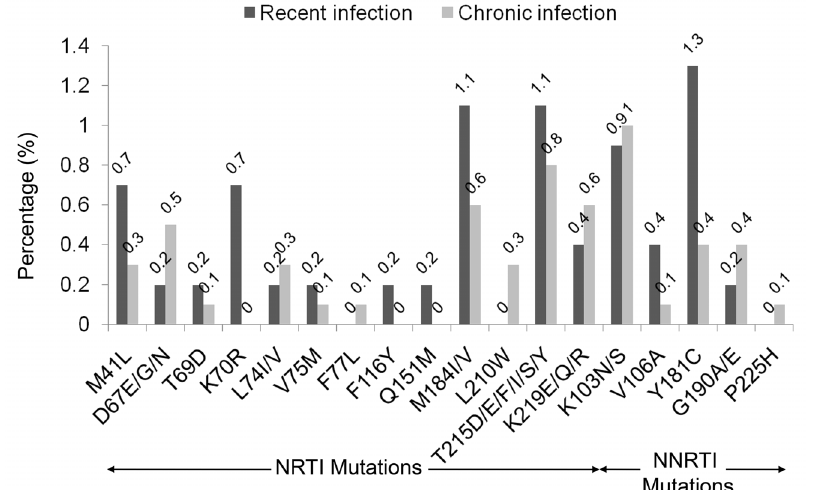
Figure 1. Distribution of reverse transcriptase resistance-associated mutations among 1,798 antiretroviral-naive HIV-infected patients. Abbreviations: NRTI; nucleoside reverse transcriptase inhibitor, NNRTI; non-nucleoside reverse transcriptase inhibitor. doi:10.1371/journal.pone.0062057.g001 PLOS ONE |